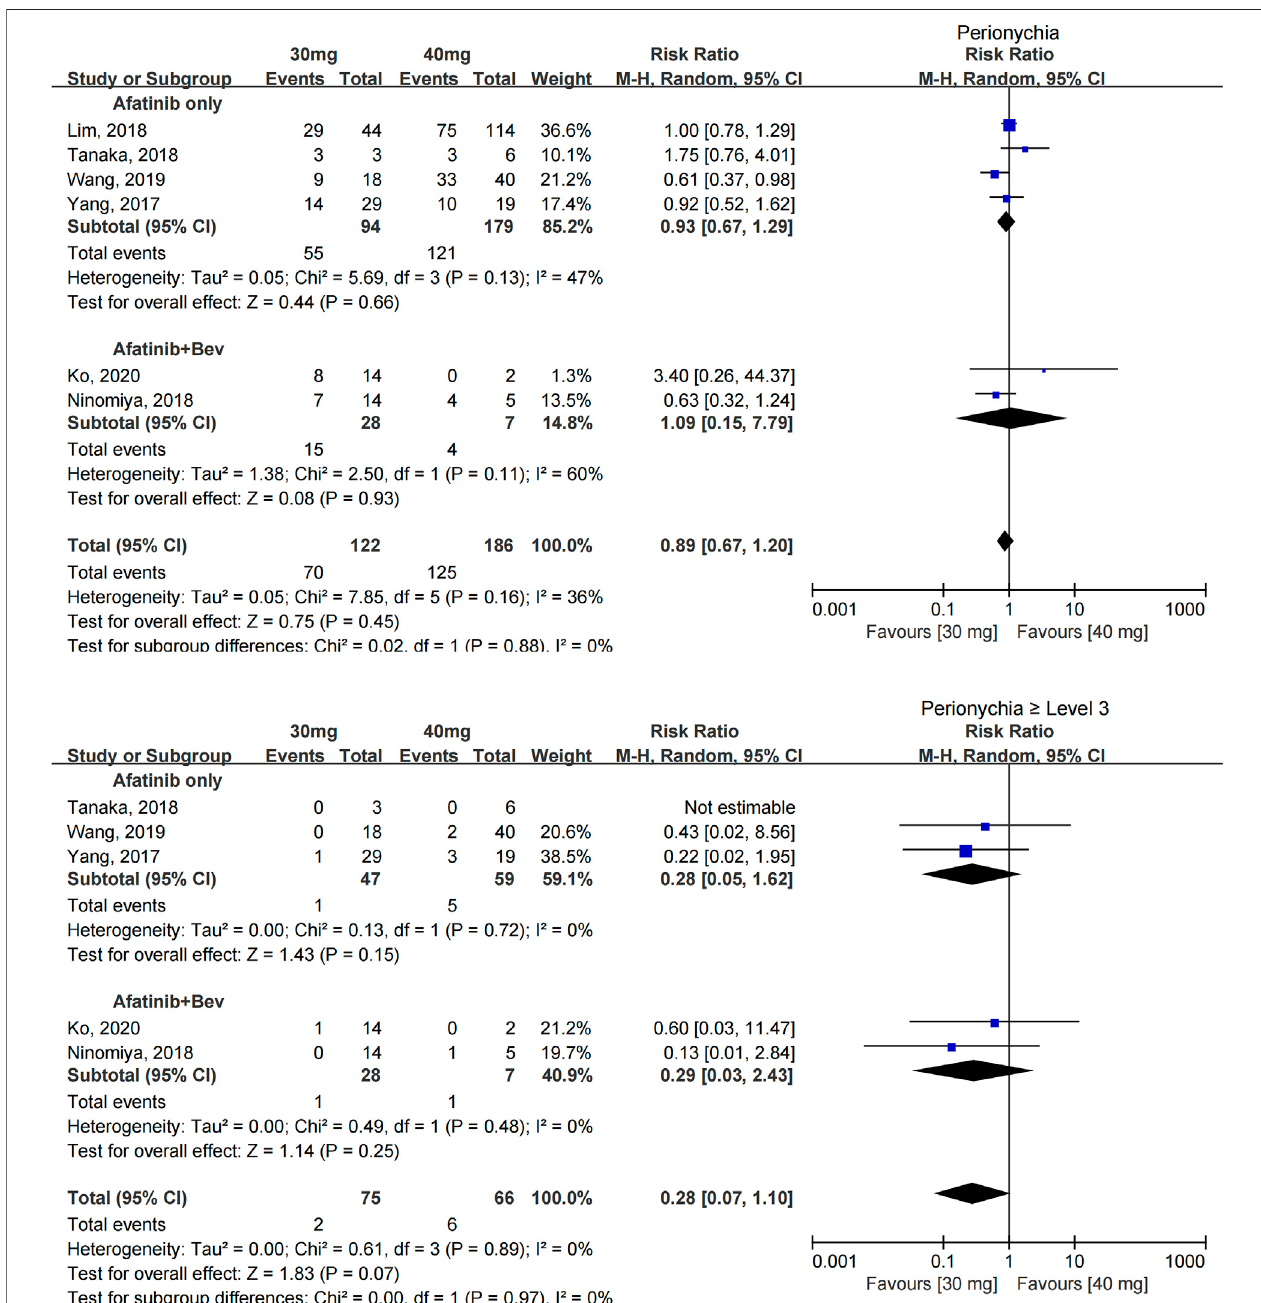
FIGURE 5 | Forest plot of the incidence of paronychia and ≥ grade 3 paronychia in the meta-analysis of patients treated with 30 and 40 mg afatinib.